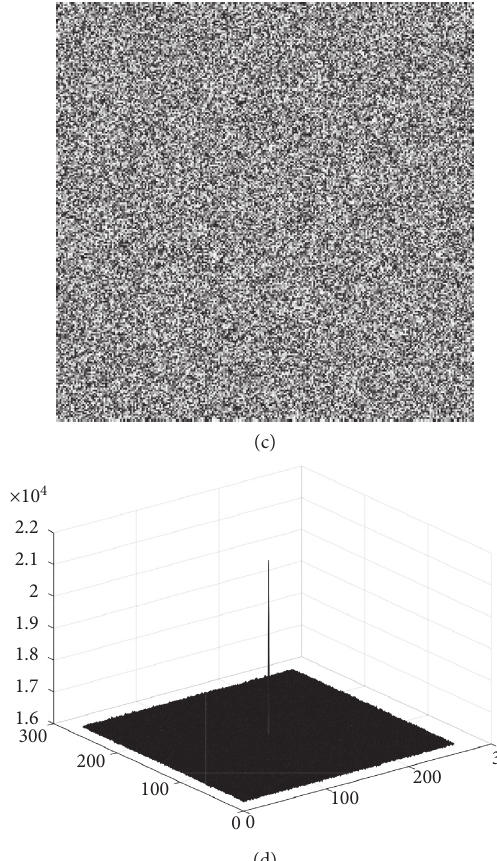
Figure 13: Graphic autocorrelation analysis: (a, c) the plain image 5.1.10.tiff and its encrypted image; (b, d) the graphic autocorrelations of (a) and (c).